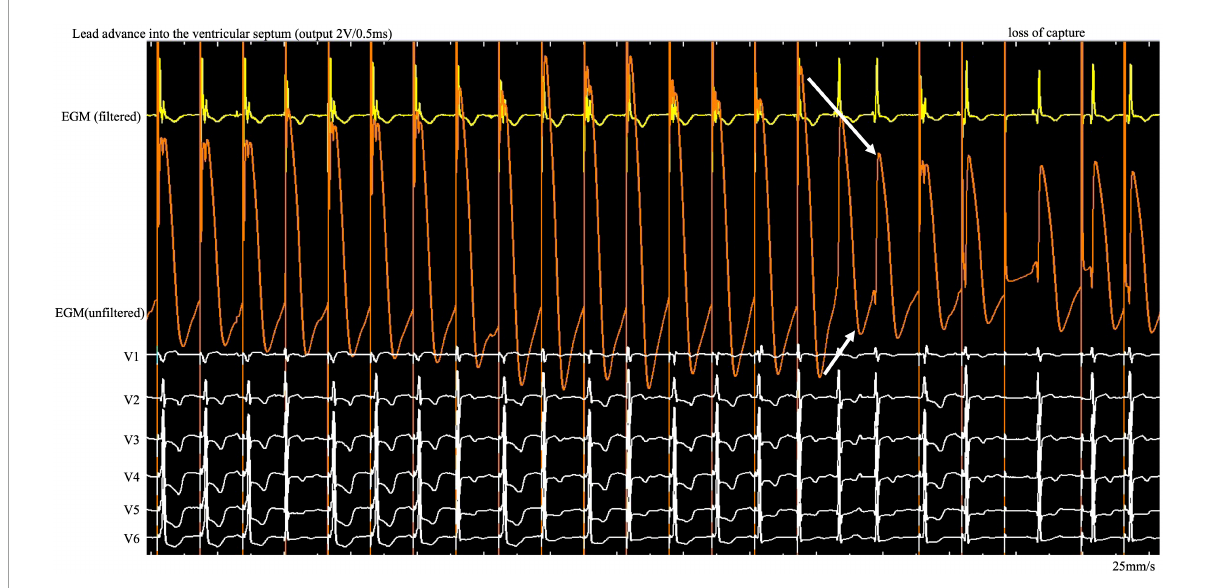
FIGURE1 During the entire screw-in process, the COI amplitude increased and then decreased gradually after reaching the peak, followed by a small but significant abrupt decrease. COI, current of injury; ECG, electrocardiogram; EGM, intracardiac